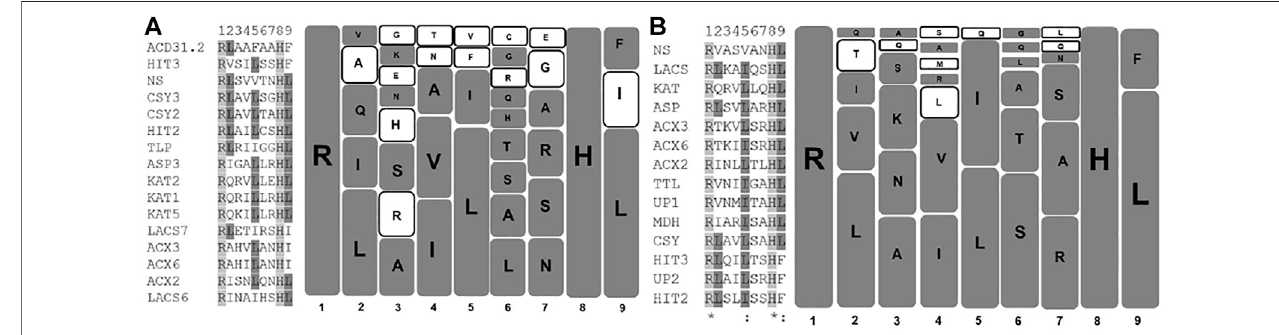
FIGURE 1| Graphical representation ofPTS2 domains of Arabidopsis thaliana and Solanum lycopersium : Unique PTS2 sequences from Arabidopsisthaliana and S. lycopersicum were taken, and a multiple sequence alignment (MSA) was performed. In the case of Arabidopsis thaliana and S. lycopersicum , 16 and 14 unique PTS2 sequences were taken for MSA, respectively. The MSA was performed at pir.georgetown.edu using the clustalW program. The left half ofthe diagram re fl ects the MSA, while the right half represents the diagrammatic representation of the amino acids present at speci fi c positions in Arabidopsis thaliana (A) and S. lycopersicum (B) . Each square represents one amino acid. The bigger the size of the squares, the higher the propensity of amino acid to remain present at that speci fi c position. The empty square represents the amino acids that differ among the two species selected here for comparison. (A) AT, (B)